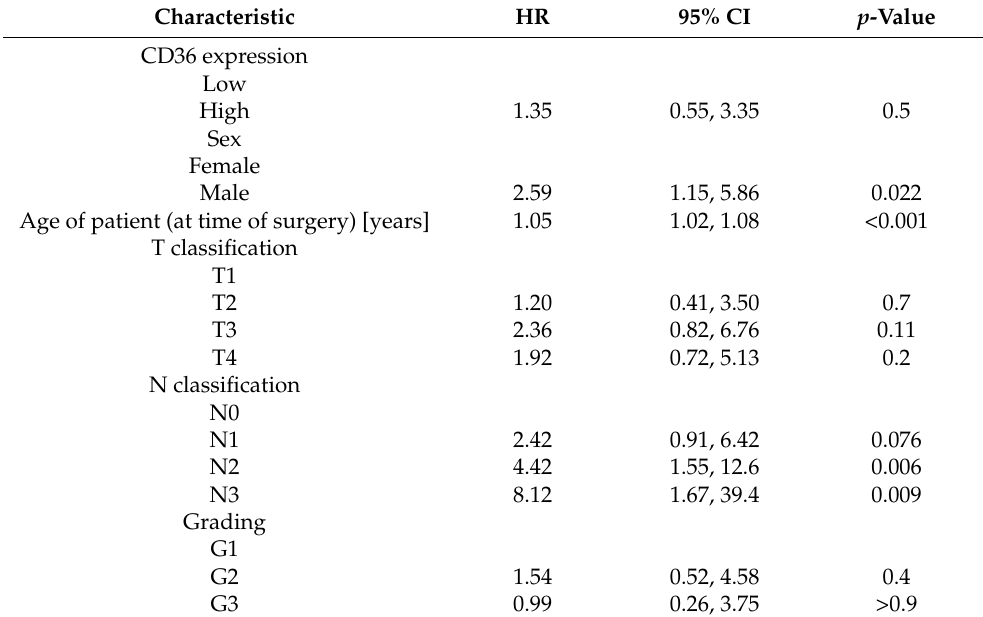
Table 5. Results of Cox regression model for progression-free survival